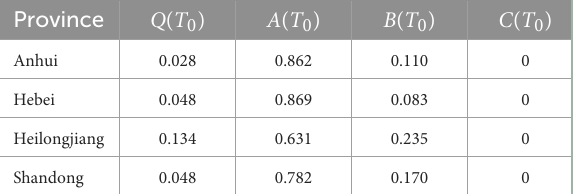
TABLE 3 Initial inputs of Q , A , B , and C